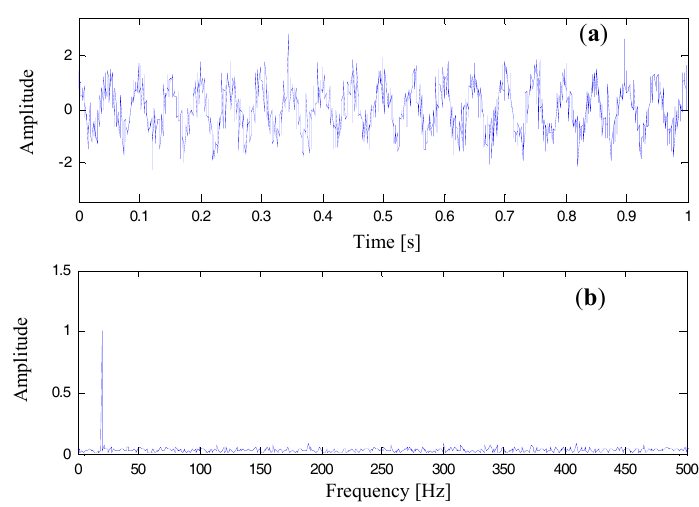
Figure 11. Plots of the simulated sinusoidal wave corrupted by white Gaussian noise (SNR = 3dB): ( a ) time domain wave; ( b ) FFT spectrum.